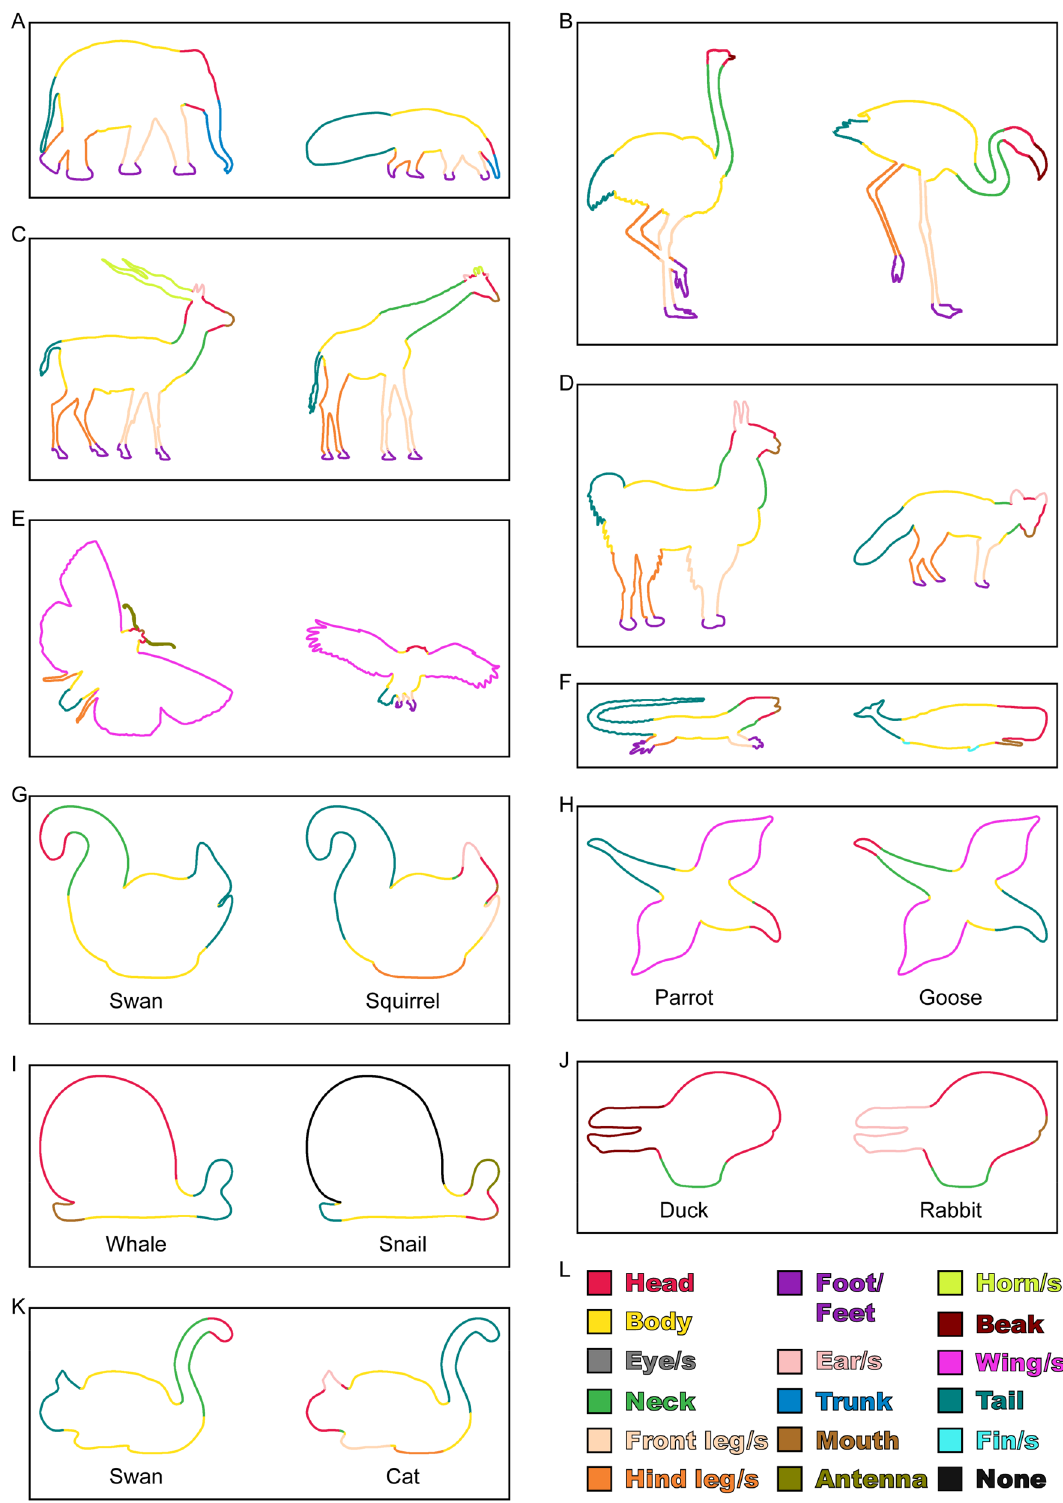
Figure 7. Overview of results of Experiment 3A. ( A – J ) On each shape, we plot for each point on the contour the most frequent label assigned to that point. ( L ) Labels and colors. Data are available at https ://doi. org/10.5281/zenod o.43042